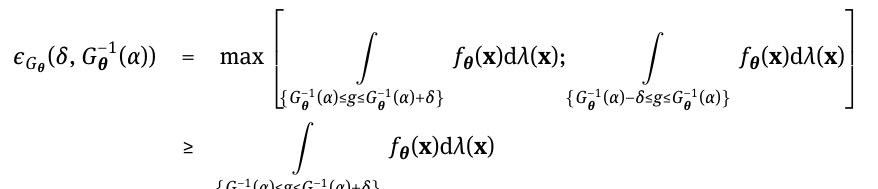
( α ) for a deviation ± δ θ